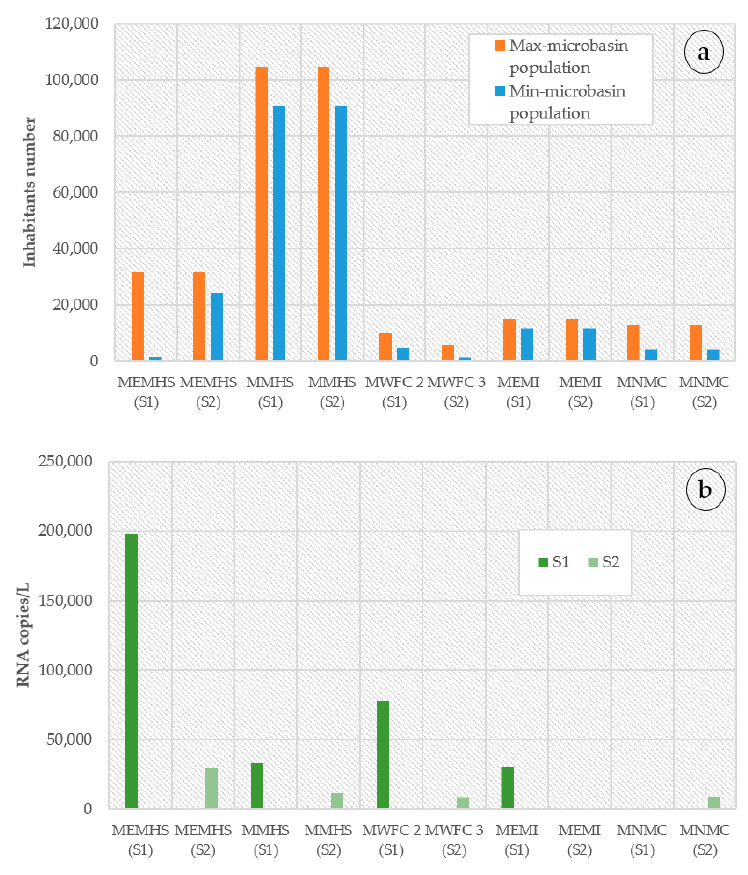
Figure 3. ( a ). The minimum and maximum micro-basin population sizes are indicated in blue and orange, respectively. ( b ). Concentration of SARS-CoV-2 RNA. The concentration of viral RNA (number of RNA copies per liter of wastewater) is indicated with dark green bars (S1 samples) and light green bars (S2 samples).